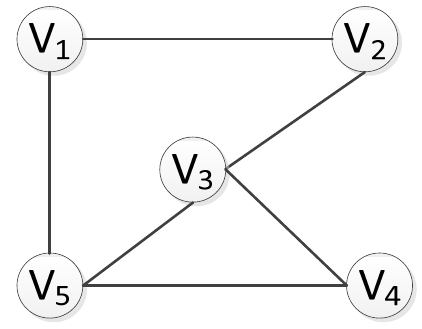
Figure 1. Schematic diagram showing connected graph with loop.